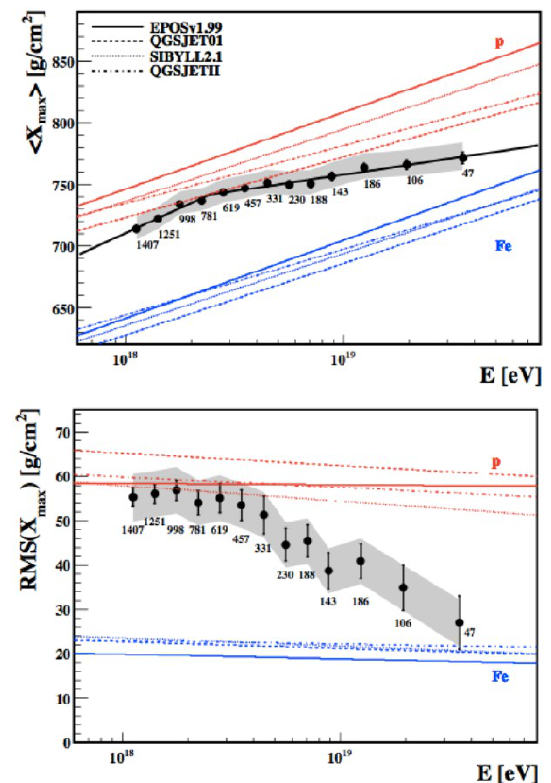
Figure 2: < X max > and RMS ( X max ) as a function of energy, compared with the predictions of air shower simulations using different hadronic interaction